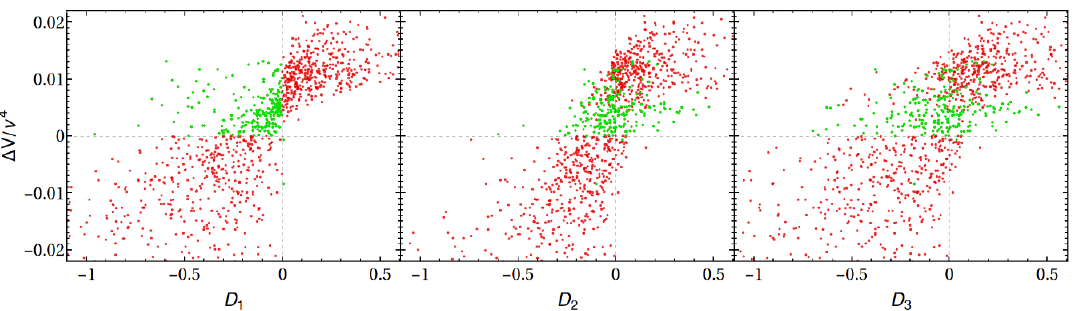
Figure 9 . Comparison of the three discriminants proposed in (7.1) in the case of regular points.